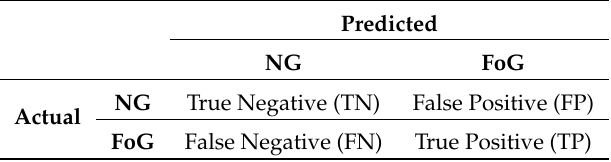
Table 2. Confusion matrix (NG: normal gait, FoG: freezing of